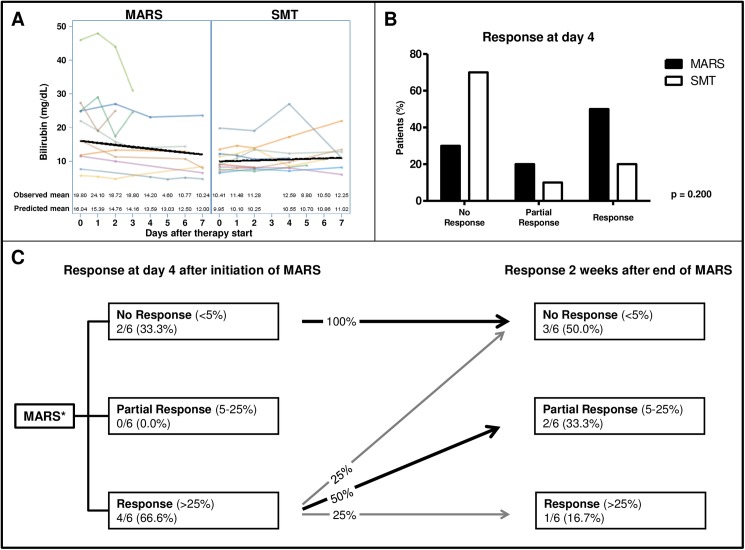
Patients with graft dysfunction: Course of bilirubin values and response to MARS treatment in the short term and 2 weeks after the end of MARS therapy.(A) Course of bilirubin values during the first week of therapy (MARS: 10 patients, SMT: 10 patients). (B) Response classification at day 4 of therapy (No response vs. Partial response vs. Response) was based on the calculated bilirubin reduction and compared to the bilirubin baseline value. (C) Corresponding response classification two weeks after the last MARS session. * Patients with liver transplantation or missing data at follow-up or those who had died were excluded from this analysis (in total, 4 patients).